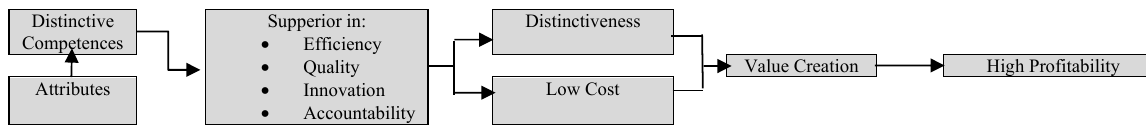
Fig. 1. Roots of Competitive Advantage Source: Hill et al.